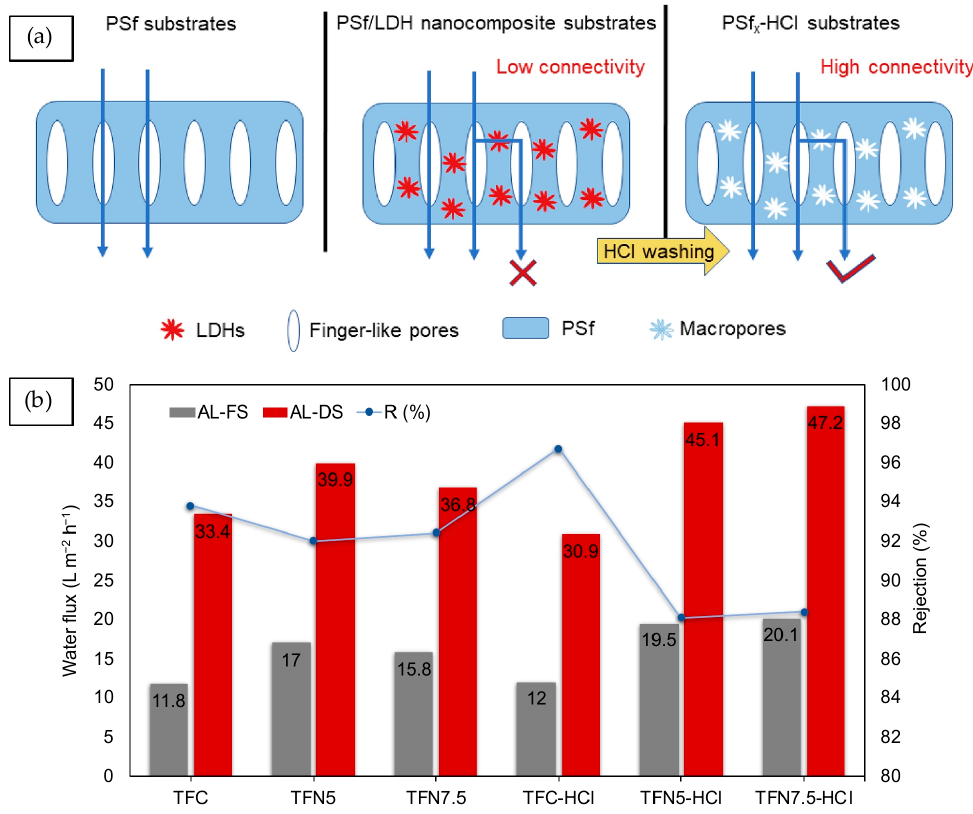
Figure 7. ( a ) Conceptual images of templating approach by preloading layered-double hydroxide (LDH) inside PSf. ( b ) Membrane with 7.5 wt % LDH etched with HCl exhibited the best of flux and NaCl rejection